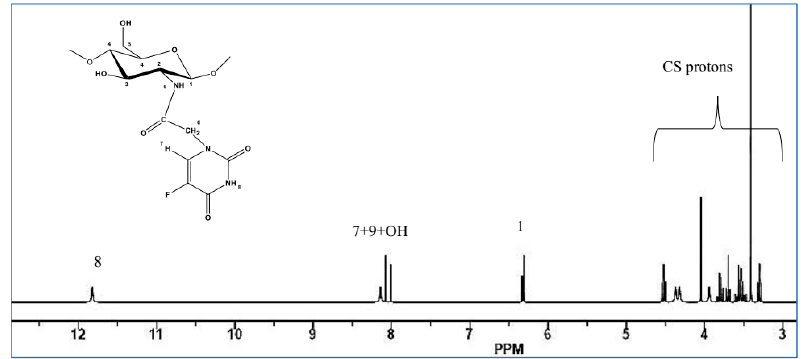
Figure 2. 1 H-NMR spectra of CS-FUAC.